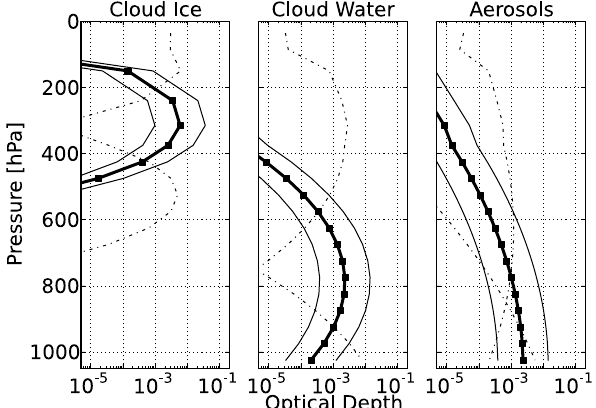
Figure 2. Prior optical depth profiles. The thick solid line with square markers shows the per-layer optical depth prior profile; the solid lines show the ± σ range applied to the optical depths; the dot- dashed lines show the ± σ range applied to the pressure